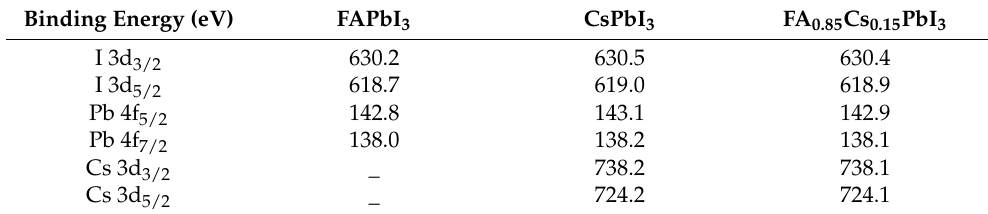
Table 1. The XPS data comparison of FAPbI 3 , CsPbI 3 , and FA0.85Cs 0.15 PbI 3 for Cs 3d, Pb 4f, and I 3d core